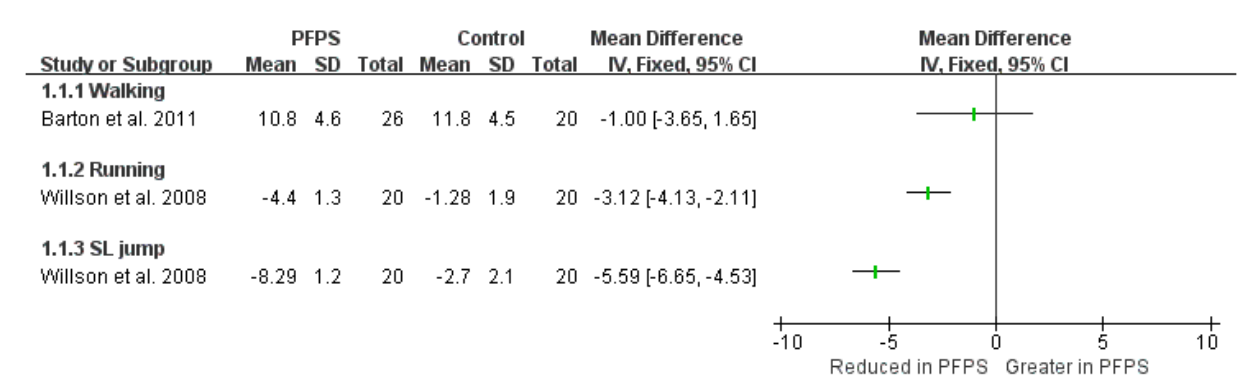
Figure 6. Knee abduction angle between the PFPS and control among the various functional activities [18,19,21].